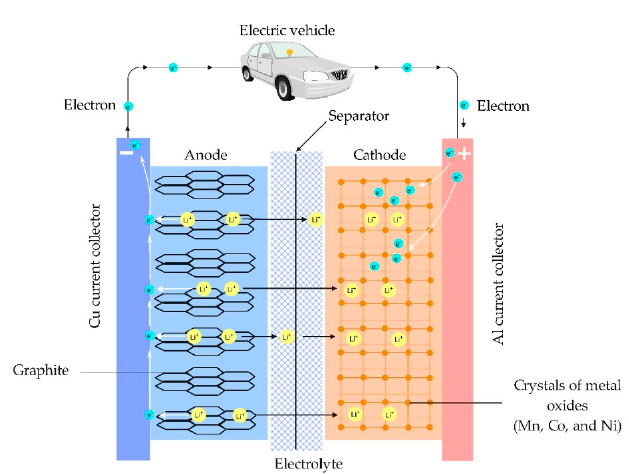
Figure 11. Lithium ions flow from the anode to the cathode and push electrons to flow within outside circuit. The electric vehicle charges in the reverse process. Adapted from [89,90].